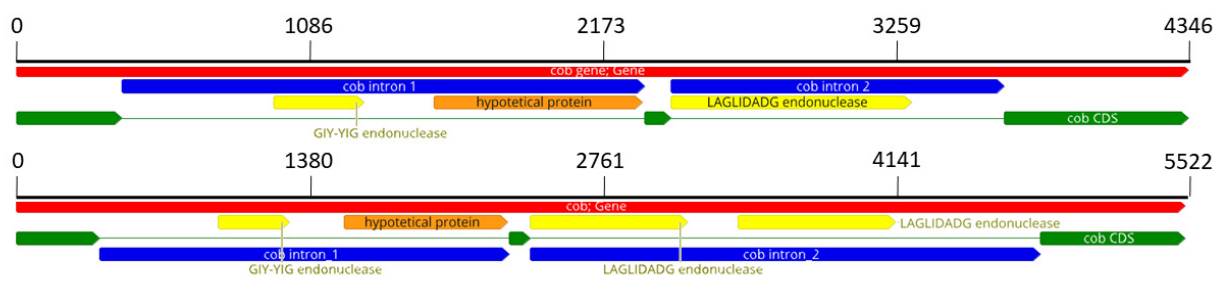
Figure 2. The two different patterns of the cob gene. On the top, the most common configuration with only one endonuclease inside the intron_2; on the bottom, the other configuration of the 4 F. musae strains with 2 endonucleases in intron_2. Red colour represents the gene, yellow and orange are respectively endonucleases and hypothetical protein while introns are in blue.